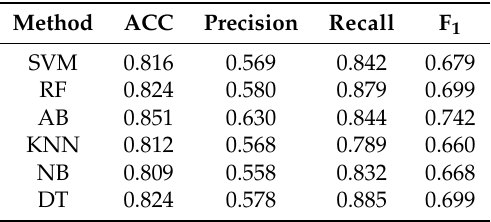
Table 3. Average results from the 14 objects and the chosen classical classifiers—support vector machines (SVM), K-nearest neighbours (KNN), naive Bayes (NB), decision trees (DT), random forests (RF) and AdaBoost